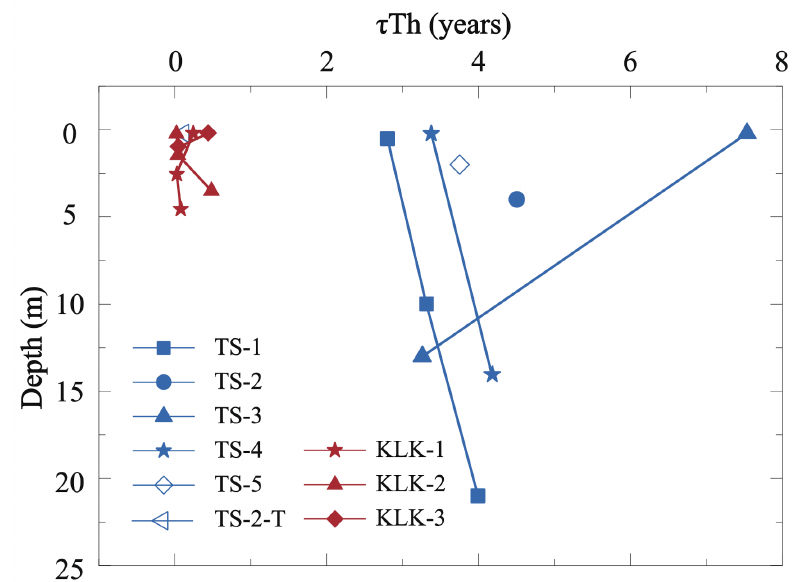
Figure 4. Distribution features of 230 Th residence time ( τ Th) in depth profiles of Tuosu Lake and Keluke